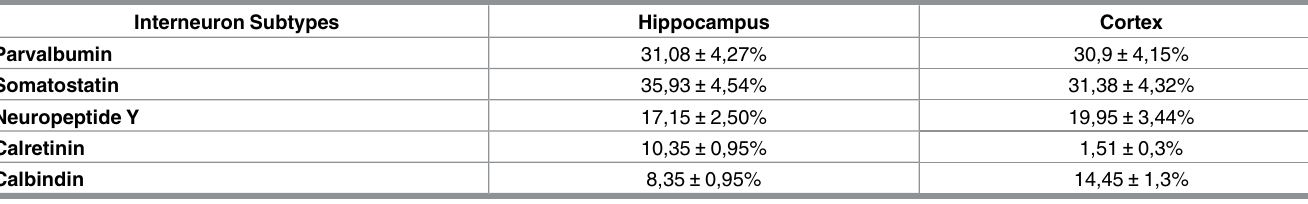
Table 3. Differentiation of MGE-derived in toto cryopreserved